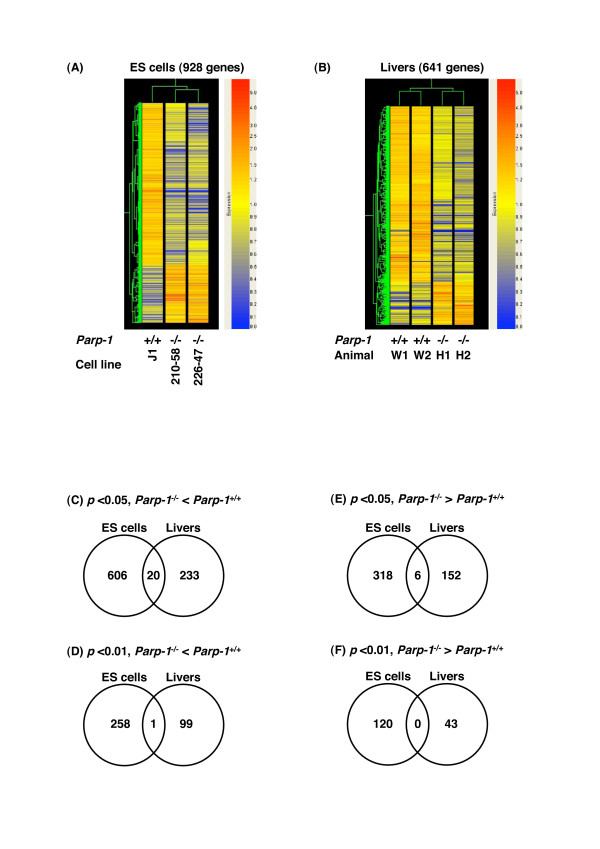
Comparison of gene expression profiles among cell lines, animals, or cell types. Heatmaps of gene expression profiles in ES cells (A) and Livers (B). We constructed the heatmaps using the gene lists containing the genes that showed a difference at p < 0.01 in ES cells and livers, respectively. Each heatmap is constructed using GeneSpring GX ver. 7.3.1. Numbers of commonly down- (C & D) or up- (E & F) regulated genes between Parp-1-/- ES cells and livers. The numbers of the genes were indicated in Venn diagrams. These genes showed the difference with at least 2-fold between Parp-1+/+ and Parp-1-/- (p < 0.05, C & E, or p < 0.01, D & F).